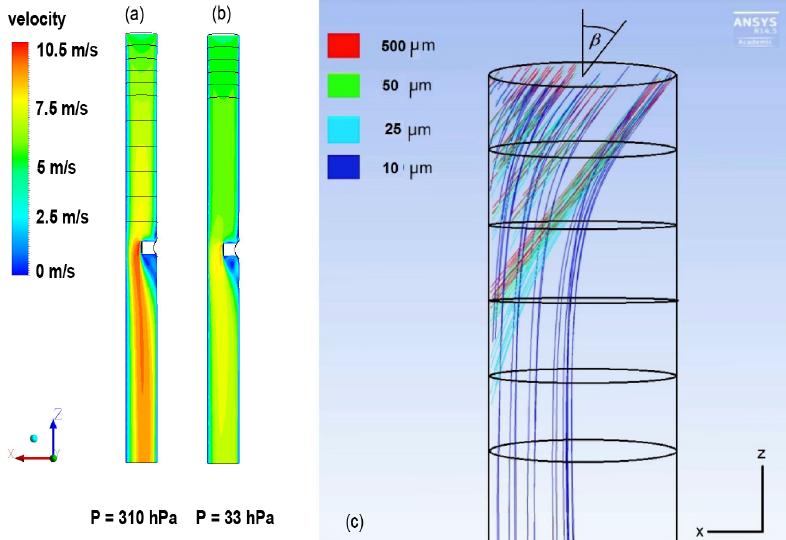
Figure 9. (a, b) FLUENT simulation results for airflow velocity (centre cut through mirror holder). (a) p = 310hPa and T =− 20 ◦ C and (b) p = 33hPa and T =− 58.7 ◦ C simulations with inlet velocity 5ms − 1 normal to the inlet plane. (c) Collision efficiency analysis based on FLUENT simulation results for particle tracks of hydrometeors with radii between 10 and 500µm (colour-coding). The figure shows the top 7cm of the intake tube. Flow simulations are for the mixed-phase cloud of flight NT011, p = 310hPa and T =− 20 ◦ C. Inlet velocity is w || = 7.5ms − 1 parallel to the tube (largely due to the balloon’s ascent velocity) and v ⊥ = 6ms − 1 perpendicular to the tube wall (largely due to the swinging motion of the payload), which results in an impact angle β of about 39 ◦ . Images used courtesy of ANSYS,